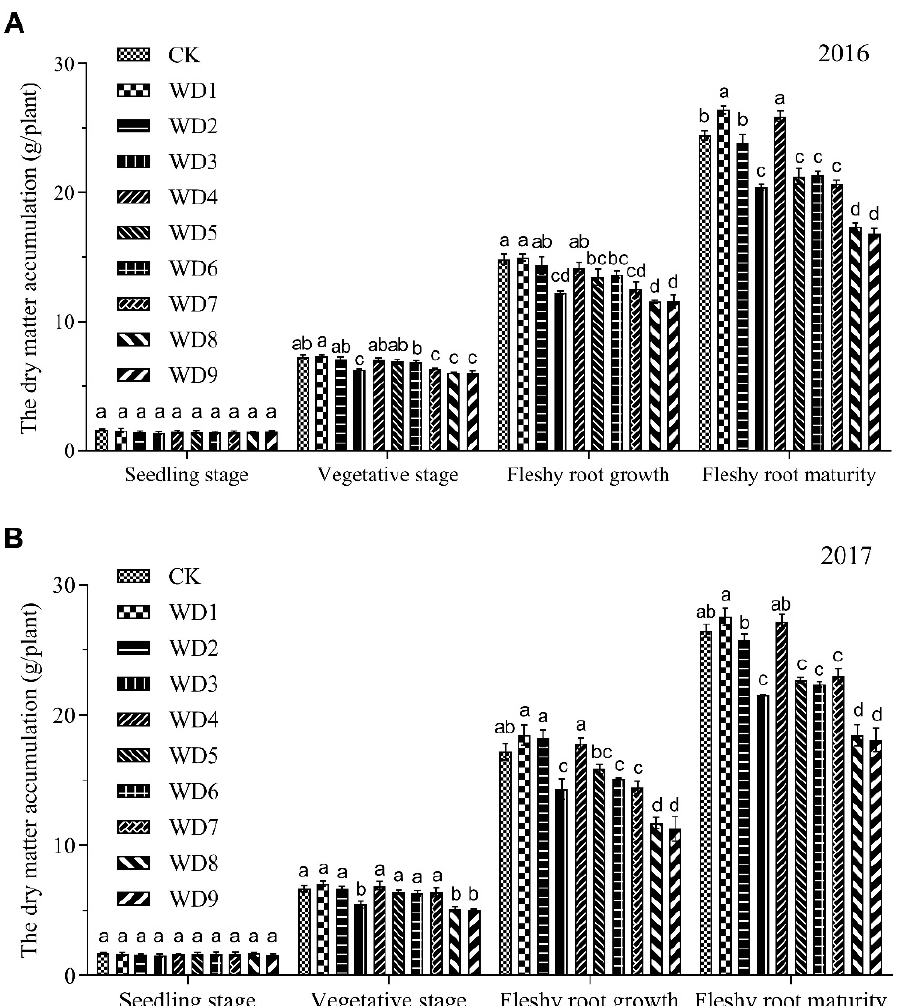
Figure 4. Dry matter accumulation of single plants under various regulated deficit treatments. Different lowercase letters within a column indicate a significant difference among treatments at p < 0.05. ( A ) The experimental data in 2016. ( B ) The experimental data in 2017. WD1: mild water deficit in the vegetative stage, WD2: moderate water deficit in the vegetative stage, WD3: severe water deficit in the vegetative stage, WD4: mild water deficit in the vegetative stage and fleshy root growth stage, WD5: mild water deficit in the vegetative stage and moderate water deficit in the fleshy root growth stage, WD6: moderate water deficit in the vegetative stage and mild water deficit in the fleshy root growth stage, WD7: moderate water deficit in the vegetative and fleshy root growth stage, WD8: severe water deficit in the vegetative and mild water deficit in the fleshy root growth stage, WD9: severe water deficit in the vegetative and moderate water deficit in the fleshy root growth stage, CK: normal water supply in all growth